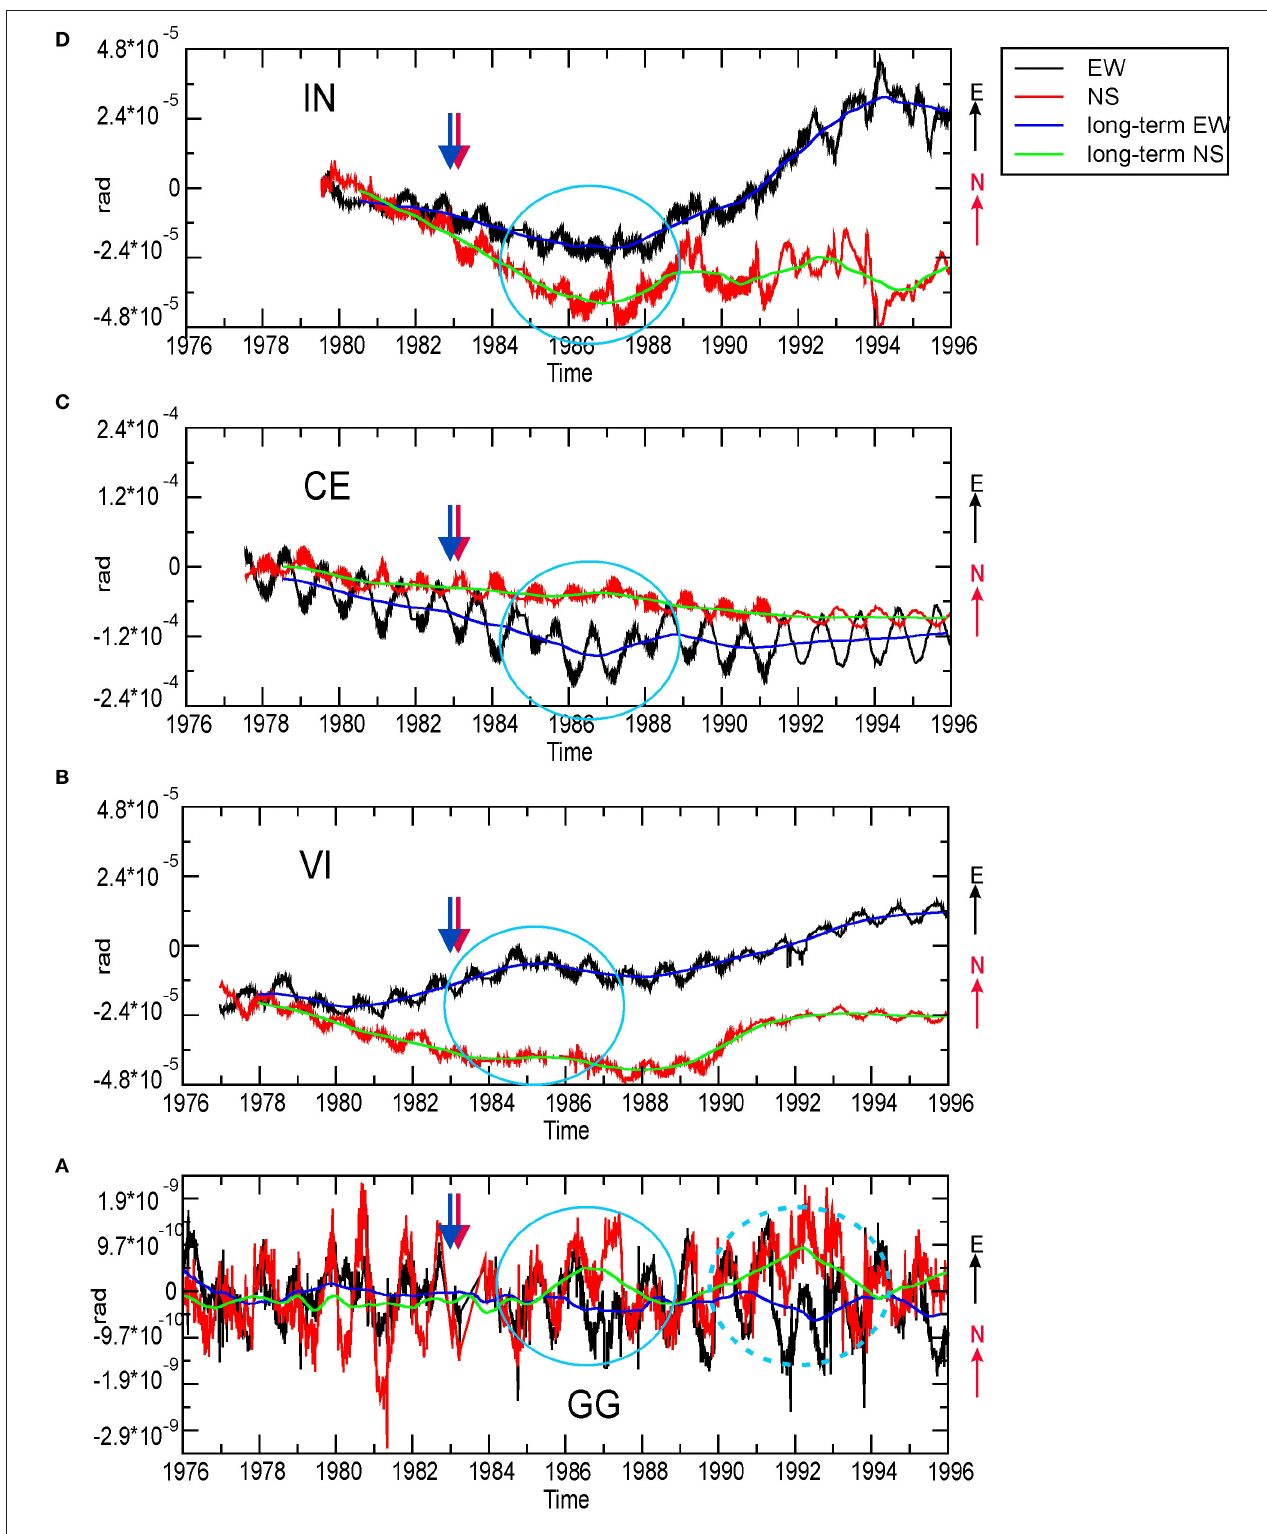
FIGURE 4 | (A–D) Tiltmeter signals for GG, VI, CE, and IN, respectively (1976–1996): original (black and red lines) EW and NS components, and the same, averaged with a running average over 2 years (blue and green lines). The blue ellipse highlights the transient signal; the blue dashed ellipse on GG signals highlights the later transient oscillation. The blue arrow indicates the transient analyzed in this study; the red arrow indicates the 1983, M D = 4.2 Uccea earthquake occurrence. X-axis: time (years). Y-axis: signal amplitude (rad). Positive: North and East, respectively.